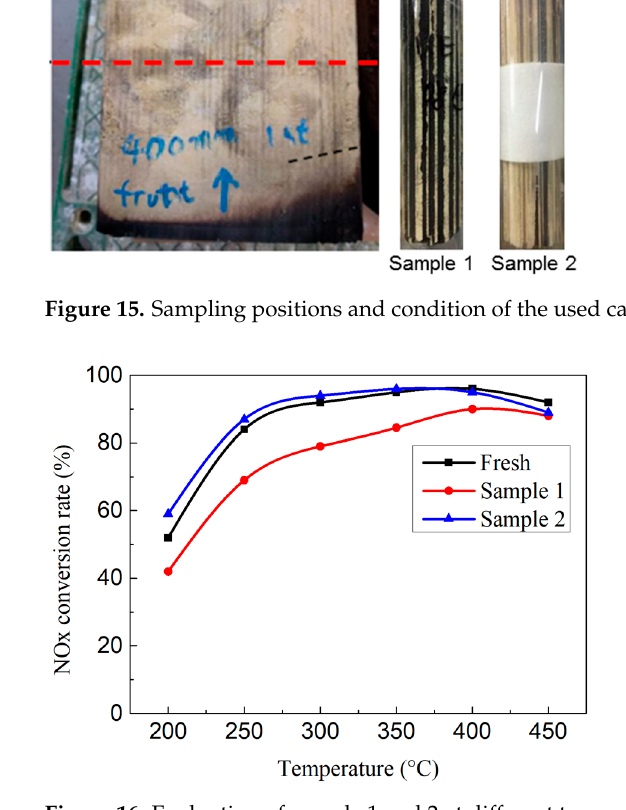
( b ) Figure 17. NOx conversion rate as a function of ( a ) HC conversion and ( b ) HC concentration from downstream of the catalyst. Catalyst Regeneration and De-NOx Performance The catalyst regeneration and De-NOx performance were investigated with the ver- ified plasma burner. As presented in Table 7, the initial De-NOx rate, De-NOx rate in the poisoned state and De-NOx rate after regeneration were compared and verified. To verify the De-NOx performance, urea water solution, which is the reducing agent of the SCR system, was supplied under the condition that the ammonia slip is minimized, assuming 1:1 reaction of nitrogen oxides (NOx) and ammonia as given in Equation (2). 4NO + 4NH 3 + O 2 → 4N 2 + 6H 2 O